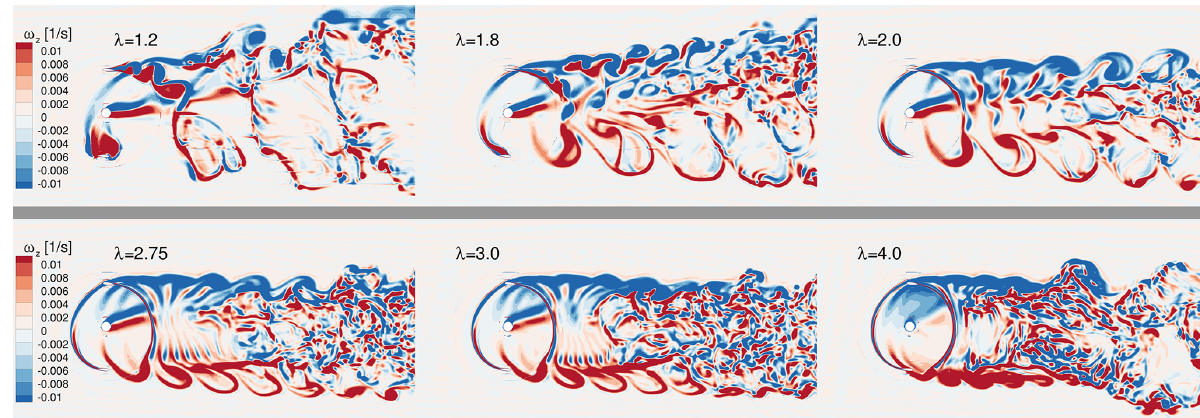
Figure 9. Z vorticity contour at different tip speed ratios.